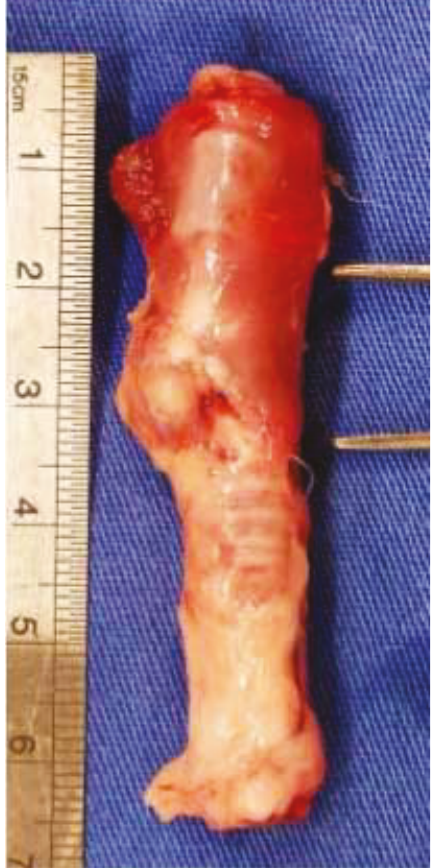
Figure 5: Trachea removed two centimeters above the main carina.